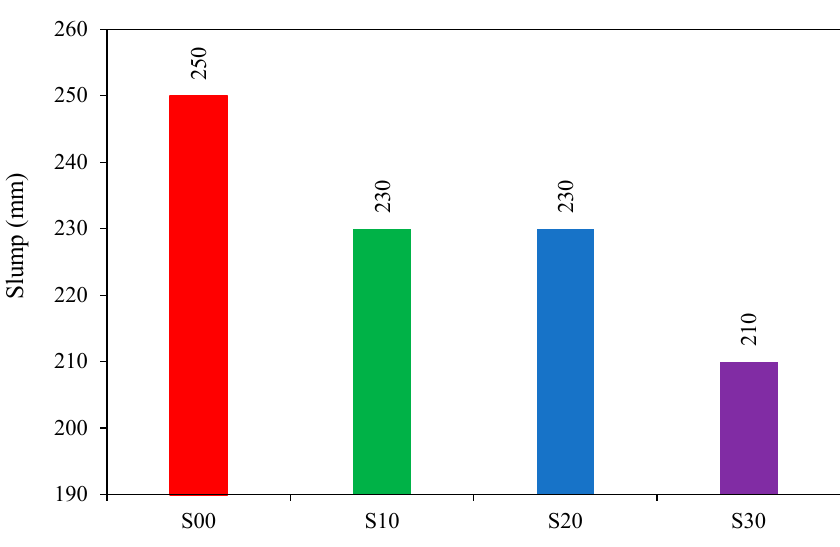
Figure 15. Slump value variation with slag content [16].